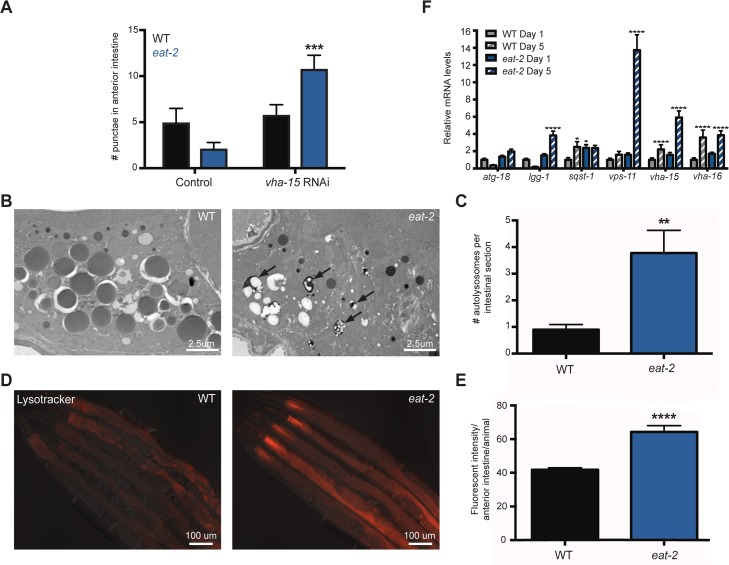
Analysis of the intestine of dietary-restricted eat-2 mutants indicate enlarged lysosomal compartment and increased autophagic flux.(A) Quantification of GFP::LGG-1 punctae in the anterior intestine of WT and eat-2(ad1116) mutants fed from the L4 larval stage to Day 4 of adulthood with bacteria containing empty vector or expressing vha15/V-ATPase-targeting dsDNA. Data are the mean ± SEM of 7–21 animals per condition. ***P = 0.0002 for RNAi control eat-2(ad1116) versus RNAi for vha-15/V-ATPase by two-way ANOVA. The experiment was repeated four times with similar results. (B) Q-PCR analysis of putative autophagy-related and lysosomal gene expression in wild-type (WT) and eat-2(ad1116) animals on Days 1 and 5 of adulthood. Data are the mean ± SEM of biological triplicates, each with three technical replicates, and are normalized to expression in the WT (N2) animals. *P<0.05, **P<0.01, ***P<0.001, and ****P<0.0001, one-way ANOVA. (C) Representative electron micrographs of intestinal cross-sections of WT and eat-2(ad1116) animals on Day 3 of adulthood. Arrows indicate autolysosome-like structures. (D) Quantification of autolysosome-like structures. Data are the mean ± SEM of 14–20 micrographs. *P = 0.0051, Student’s t-test. (E) Representative images of overlaid fluorescence and differential interference contrast (DIC) channels showing the intestine of 5-day-old WT and eat-2(ad1116) adult animals labeled with LysoTracker Red DND-99. (F). Quantification of fluorescence intensity in the anterior intestine. Data are the mean ± SEM of 10 animals. *P<0.0001, Student’s t-test. The experiment was repeated six times with similar results.